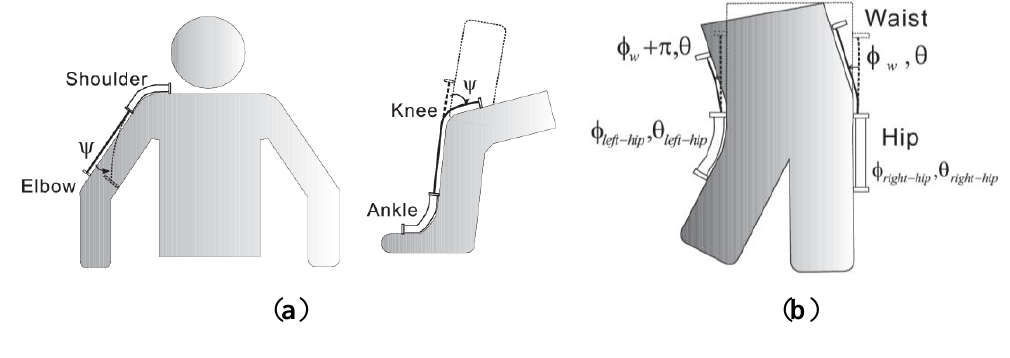
Figure 5. Advanced mode ( a ) Application on an additional unaxial joint angle. Left: Add torsion angle to shoulder joint measurement. Right: Add knee angle to ankle joint; ( b ) Additional measurement of ϕ and θ of waist by employing two hip w w